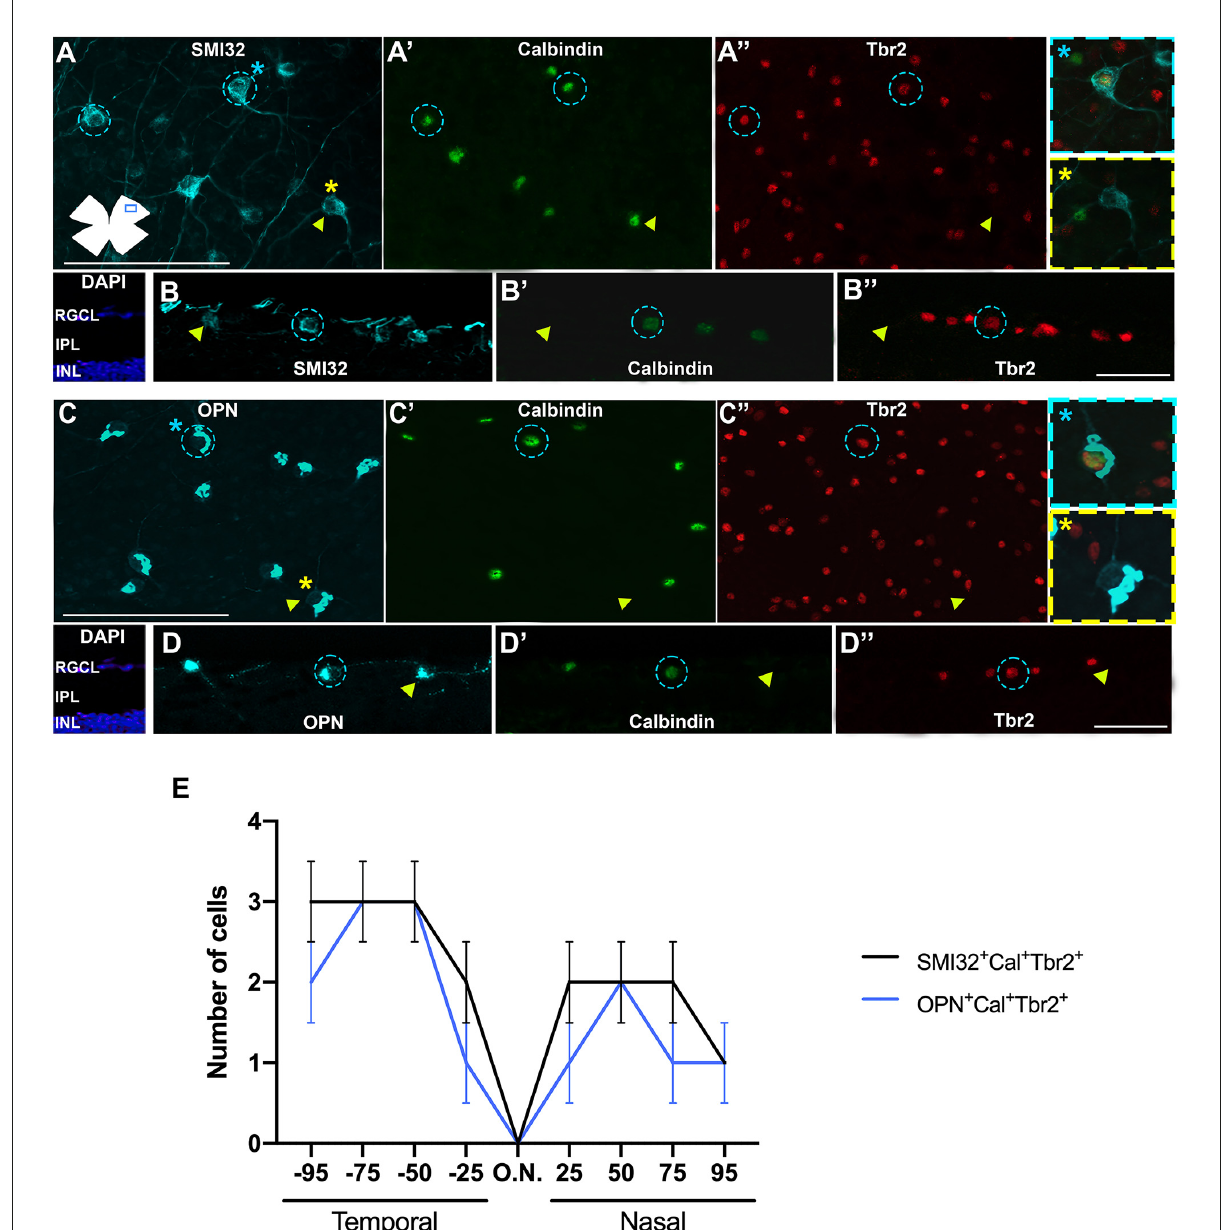
FIGURE5 Immunohistochemical detection of ONs- α RGCs. Photomicrographs of flat-mounted retinas (A–A”,C–C”) or radial retinal sections (B–B”,D–D”) immunodetected against the α RGC pan-marker SMI32 (A) or OPN (C) in blue, Calbindin (A’,C’) in green and Tbr2 (A”,C”) in red in the same area of the retina. Note that calbindin and Tbr2 label the cell nuclei while SMI32, and OPN mark the cytoplasm of the soma and proximal axons. ONs- α RGCs were detected as SMI32 + Cal + Tbr2 + or OPN + Cal + Tbr2 + . (E) Graph illustrating manual counting of SMI32 + Cal + Tbr2 + (black line) or OPN + Cal + Tbr2 + (blue line) in different regions of the retina, from 25-50-75-90% temporal to 25-50-75-90% nasal. In panels (A–D”) , blue circles represent cells positive for all three markers (SMI32 + or OPN + and Calbindin + and Tbr2 + ) merged in the panel with a blue asterisk and yellow arrowheads represent cells positive for the RGC pan-marker (SMI32 + or OPN + ) but negative for Calbindin or Tbr2 merged in the panel with a yellow asterisk. Scale bar: 100 µ